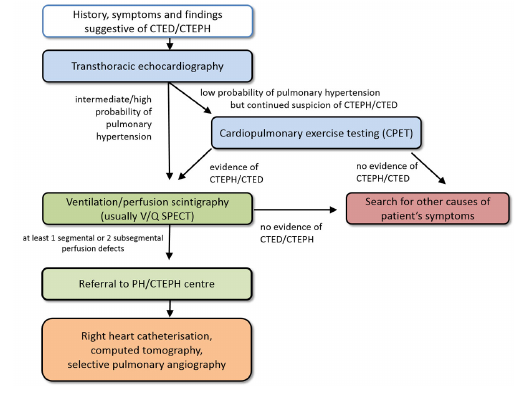
Figure 3: CTEPH diagnostic algorithm. Adapted from Wikens H, Ulrich S, consensus conference Cologne, 2016. CTED = chronic thromboembolic pulmonary vascular disease; CTEPH = chronic thromboembolic pulmonary hypertension; PH = pulmonary